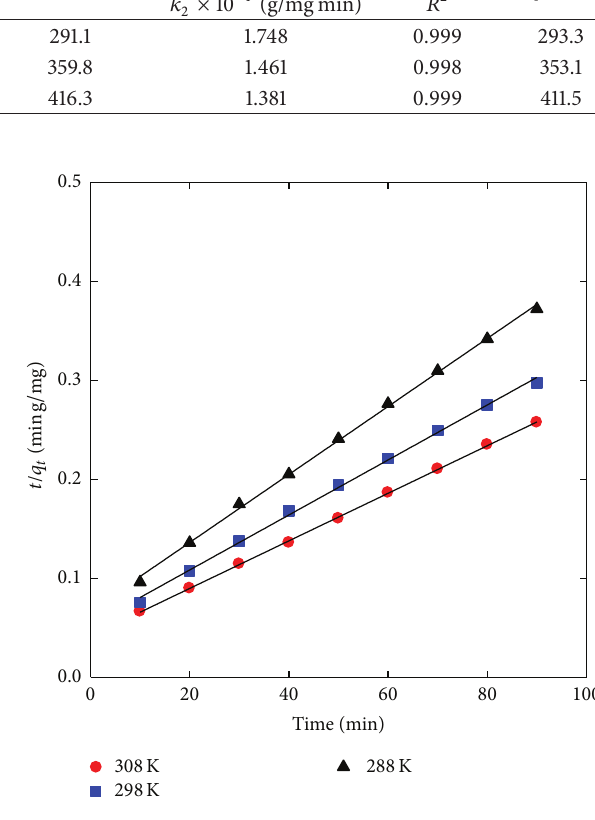
Figure 5: Linearized pseudo-first-order kinetic model of Gardenia blue on TiO 2 thin film at different temperature.